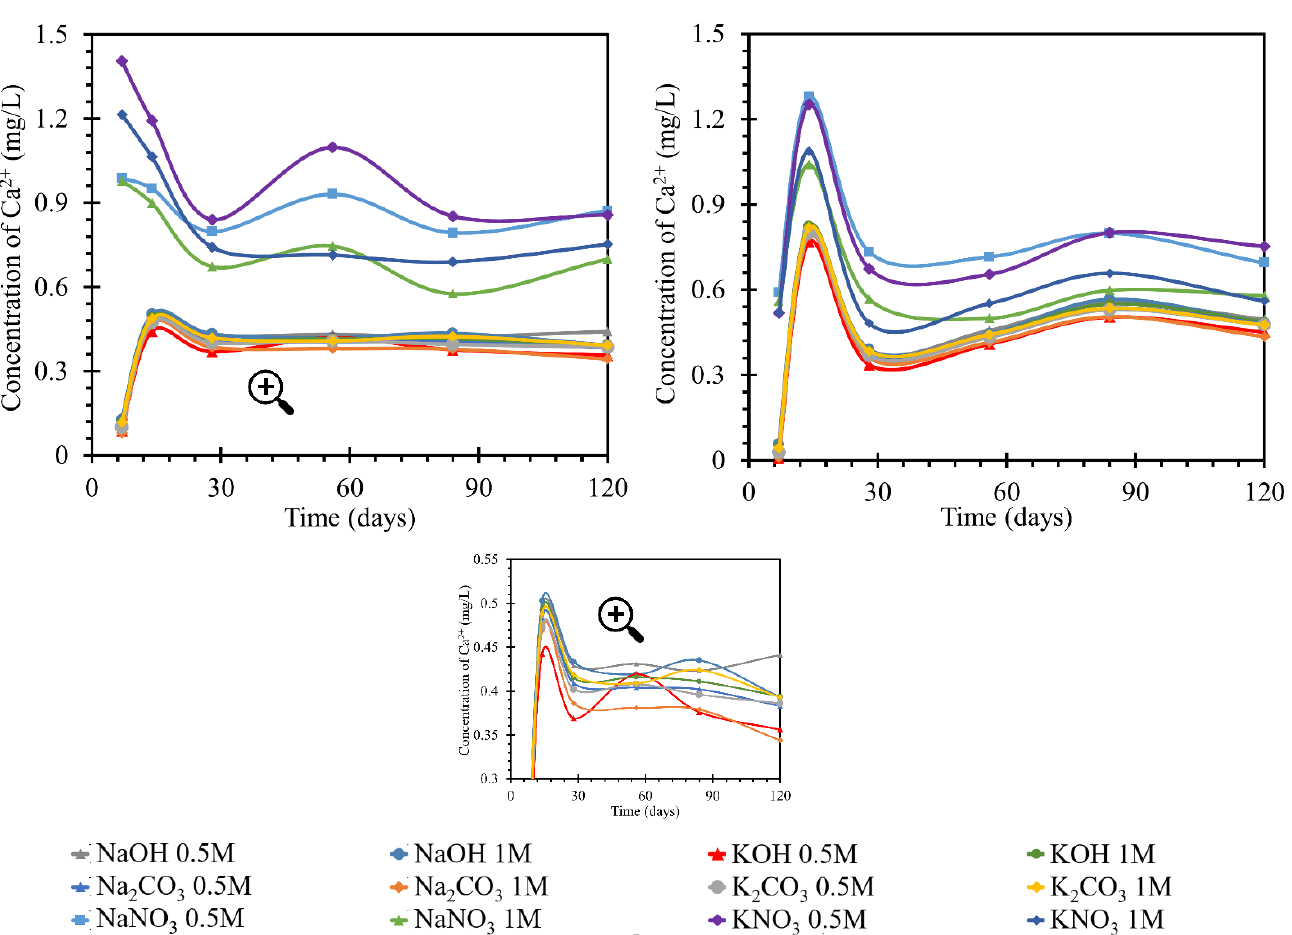
Figure 4. Results of monitoring calcium ion concentrations in individual solutions, on the left at the laboratory temperature of 25 °C, on the right at 40 °C. The Ca 2+ concentrations were determined using the ICP-OES method; for clarity, the error bars are not shown, but they reach a 1.83% maximum.